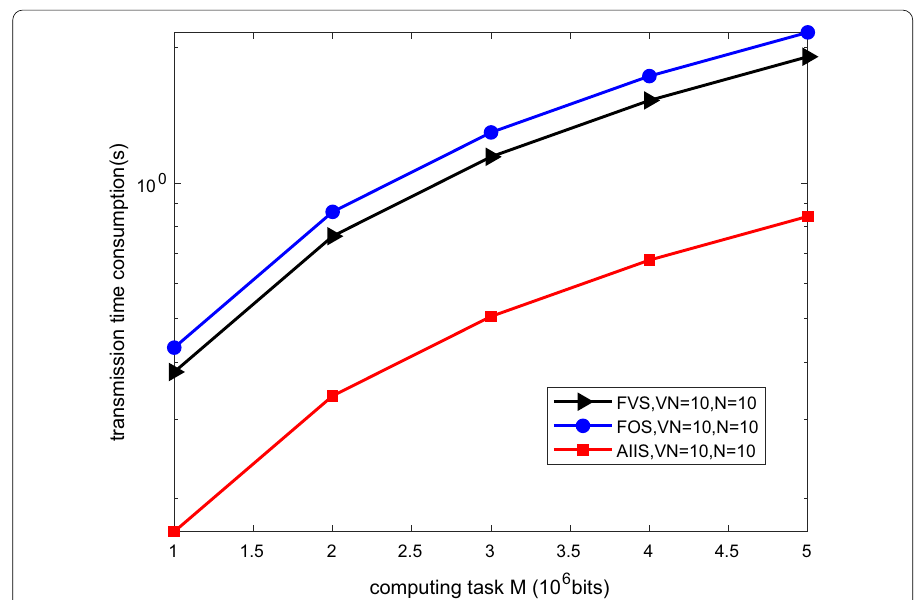
Fig. 7 The transmission time consumption of vehicle nodes (VNs) versus the computation task M